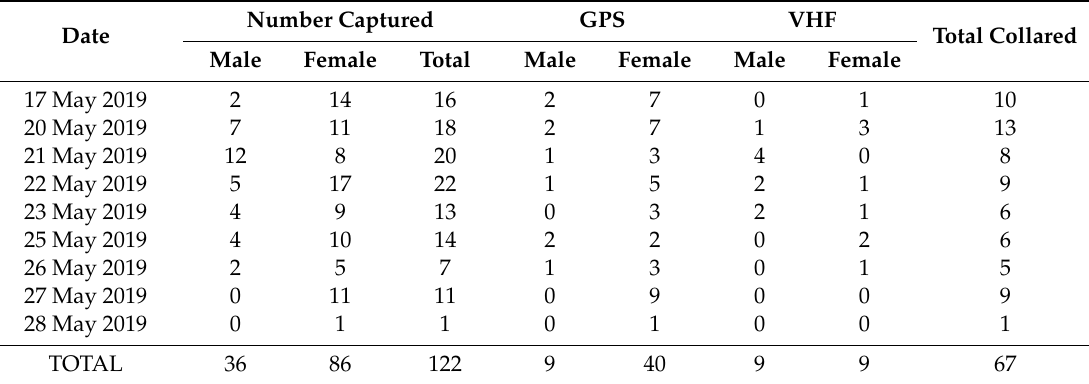
Table 1. Number of individual western grey kangaroos, sex and collar type (GPS: Global Positioning System or VHF: Very High Frequency) fitted on each day of